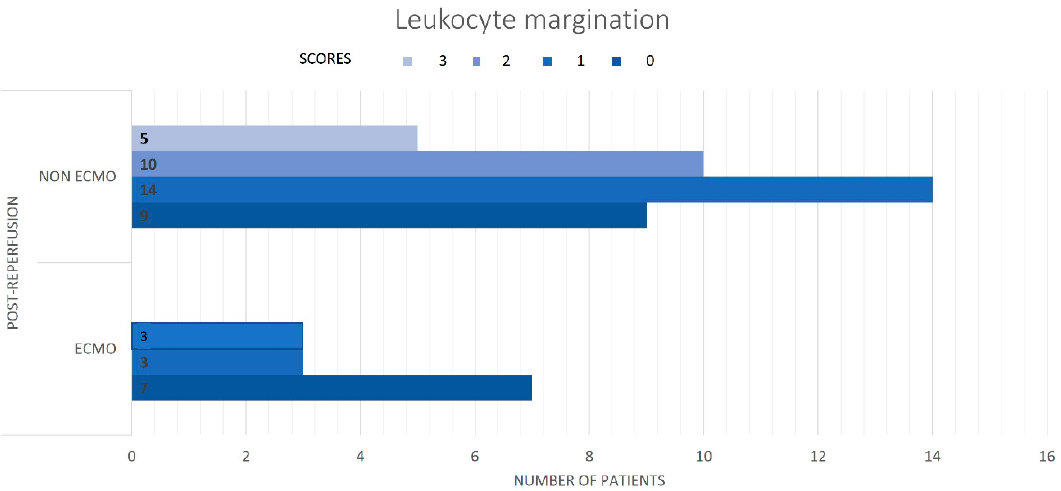
Figure 3. Distribution of scores for leukocyte margination in ECMO and non-ECMO patients post- reperfusion. In patients without ECMO, leukocyte margination scores were mostly 1–3 rather than 0.